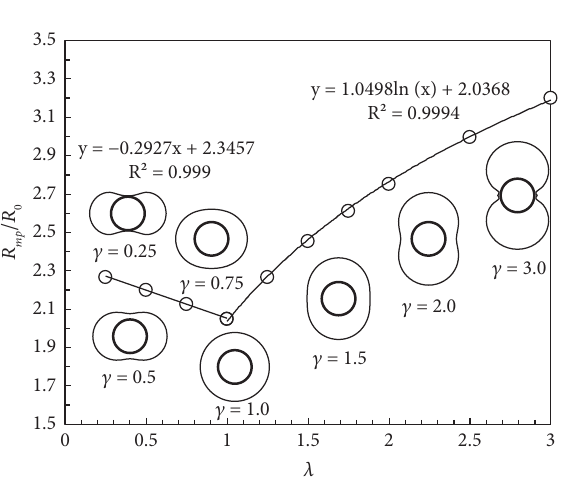
Figure 6: The plastic zone and relationship between λ and R